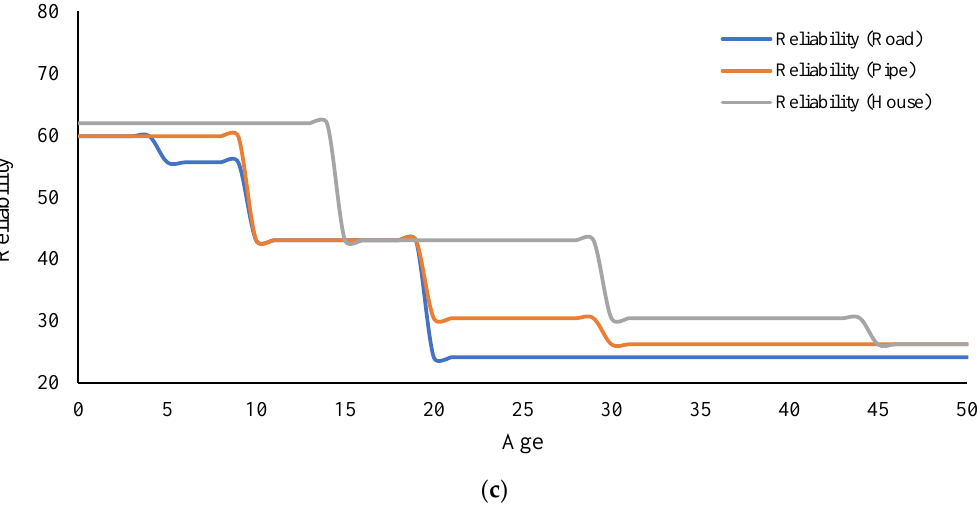
Figure 4. Infrastructure reliability curves due to swelling. ( a ) 27 to 32 GWC, ( b ) 32 to 37 GWC, ( c ) 37 to 42 GWC.